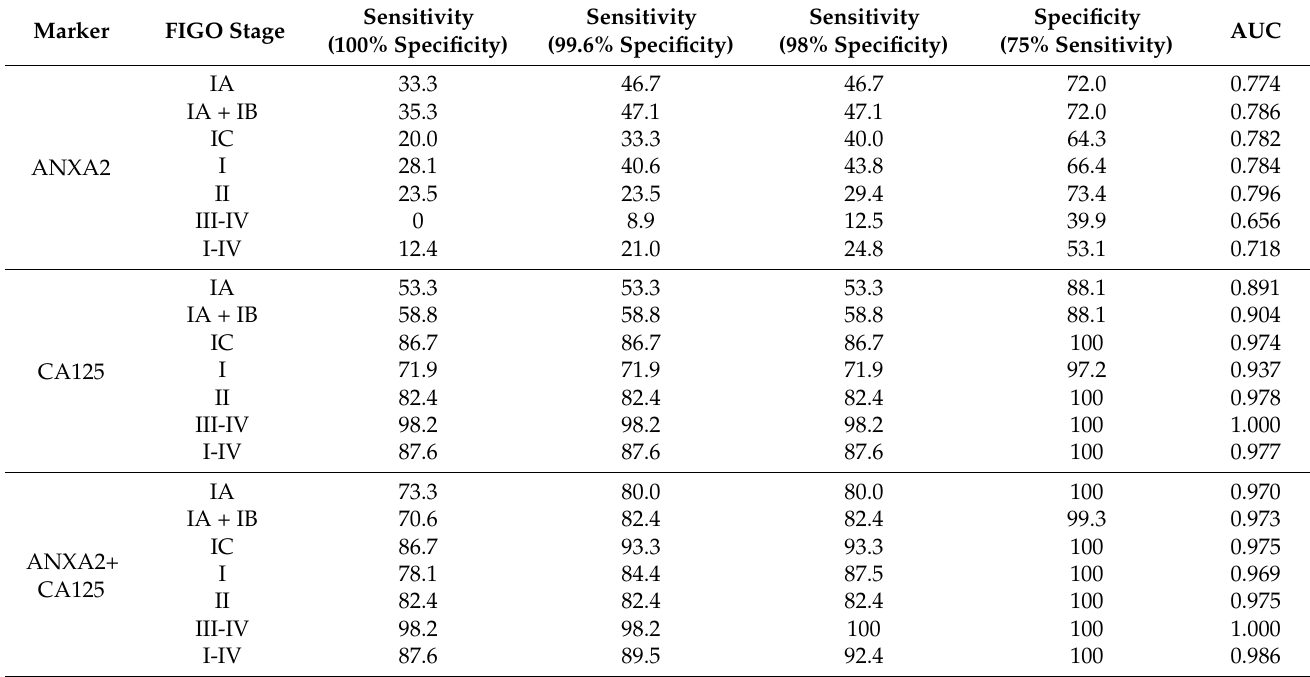
Table 1. Sensitivity (%) of ANXA2, CA125 and ANXA2 + CA125 at 100%, 99.6% and 98% specificities, specificities (%) at fixed sensitivity (75%) and AUC from the ROC curve for stage I-IV OC versus healthy controls using the logistic regression model.